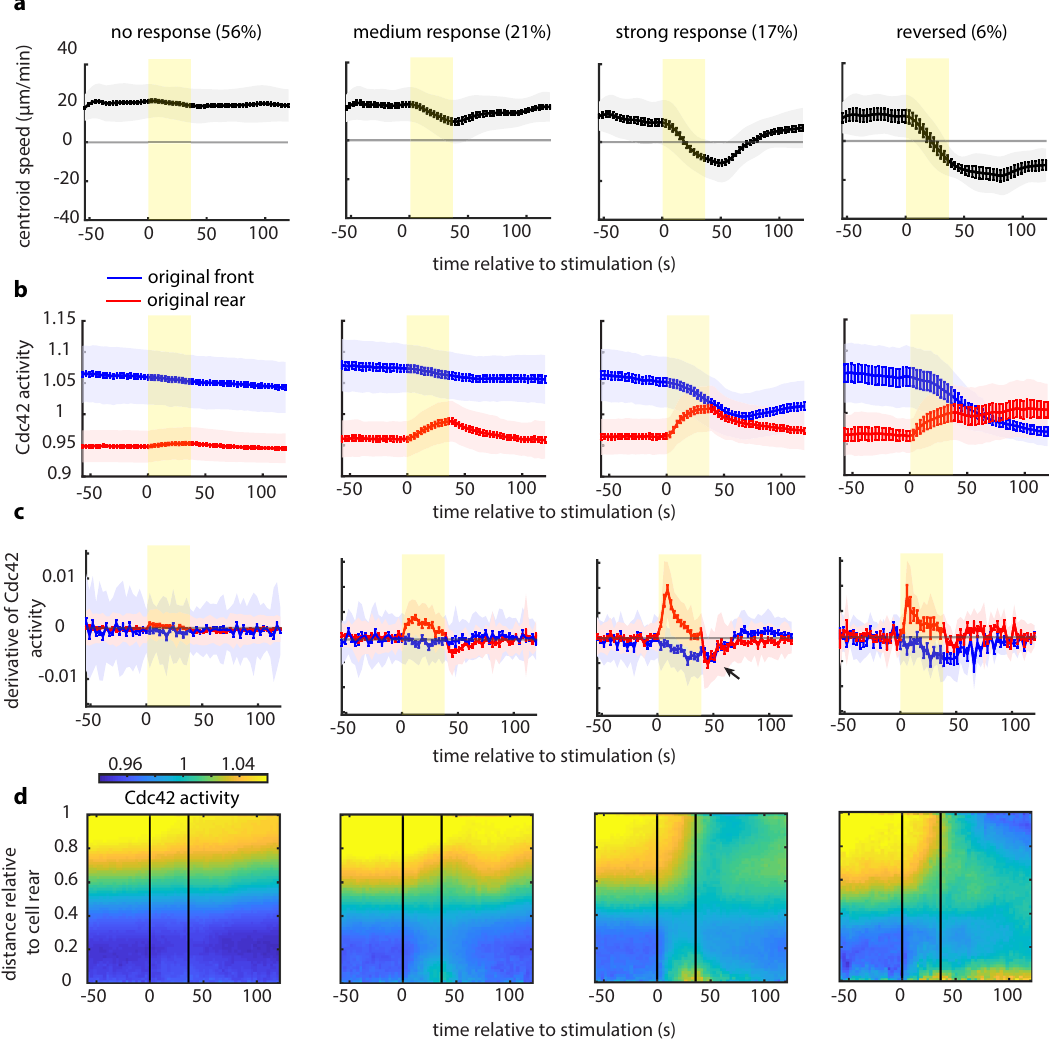
Fig. 4 A strong cell rear is refractory to receptor inputs. a – c Cell centroid speed ( a ), mean Cdc42 activity ( b ), and derivative of Cdc42 activity ( c ) at the original front (blue) and rear (red) over time for each cellular response (lines: means, shaded regions: SD, error bars: mean value ± SE). Data are averages from n = 141 non-responders, n = 49 medium responders, n = 44 strong responders, and n = 11 reversers from 20 independent experiments. Rectangular yellow shaded region marks the start and end of the 12-pulse stimulation. d Average kymograph representation of Cdc42 activity as a function of time ( x - axis) and vertical position relative to the cell rear ( y -axis) for non-responding, medium responding, strong responding, and reversing cells. Vertical black lines indicate the start and end of the pulsated stimulation. Source data are provided as a Source Data fi